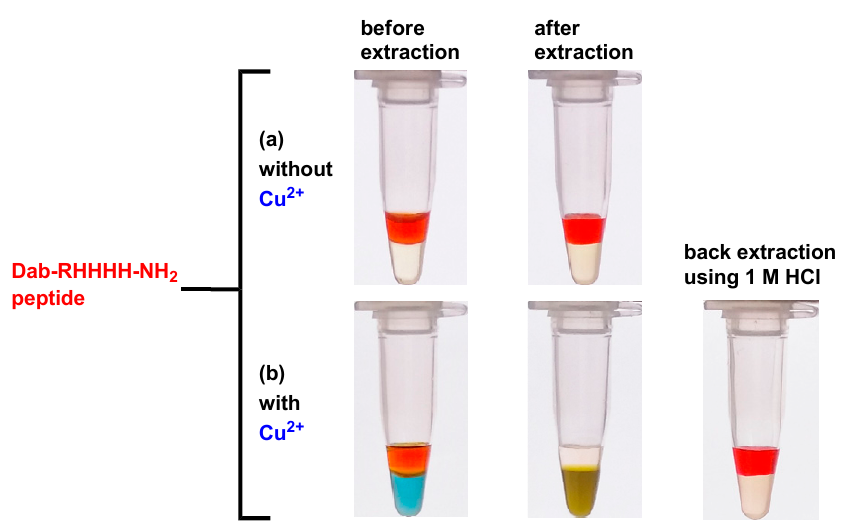
Figure 6. Affinity extraction of the dabsylated His-containing pentapeptide amide Dab-RHHHH-NH 2 (1 mM) in 200 mM NaOAc buffer (pH 4.4) containing 10% DMSO (upper layer, 25 μ L) by AIL 3 (100 mM) solubilized in ionic liquid 1 (bottom layer, 25 μ L). ( a , b ) are optical photographic images of peptide extraction into ionic liquid layer without and with chelated Cu 2+ (50 mM), respectively. Back extraction of the peptide in ionic liquid layer into aqueous layer could be conveniently achieved using 1 M HCl solution (upper layer, 25 μ L).